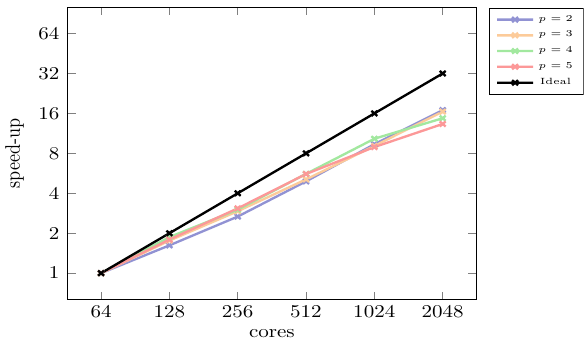
Fig. 11 Speed-up with MGRIT using V-cycles and backward Euler on the unit cube. Here p -multigrid is used for all spatial solves within